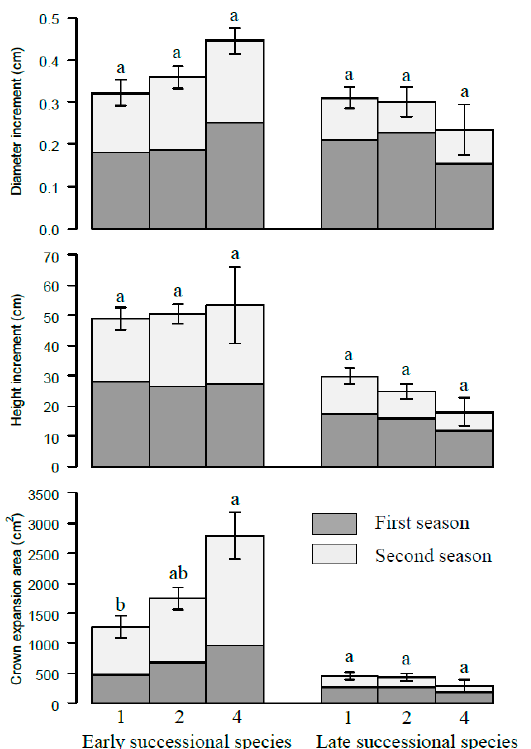
Figure 4. The increments of diameter, height, and crown projection area of different successional species at different species richness levels. The numbers 1, 2, and 4 represent monoculture, two species and four species mixtures, respectively. Bars represent means ± SE. Different letters indicate significant differences among different species richness levels, p < 0.05.